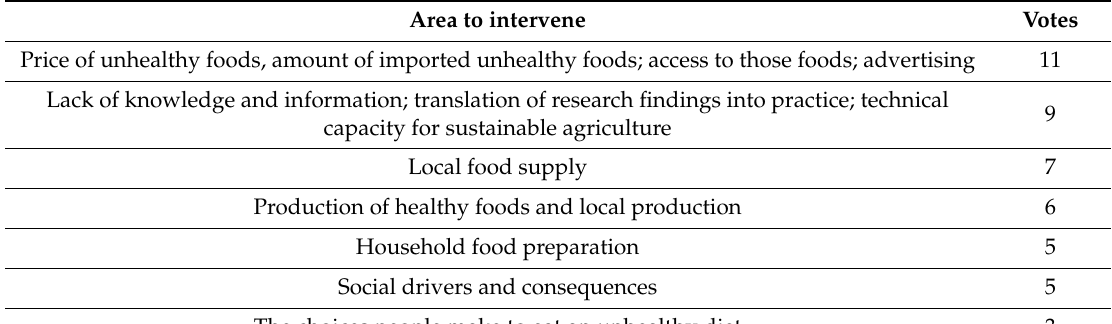
Table A1. Summary of places to intervene with priority rankings and votes, Jamaica workshop. Area to intervene Price of unhealthy foods, amount of imported unhealthy foods; access to those foods; advertising Lack of knowledge and information; translation of research findings into practice; technical